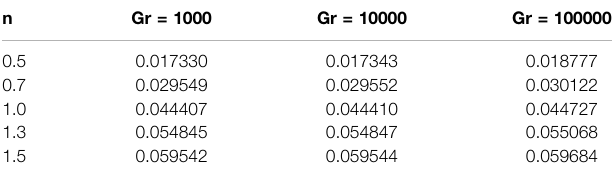
TABLE 3 | Impact of n on the kinetic energy for different values of Gr